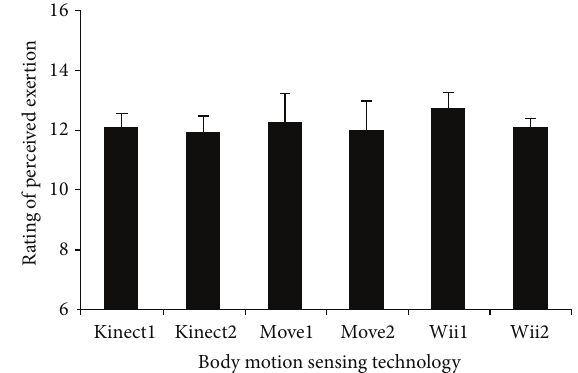
Figure 4: Rating of perceived exertion reported immediately after performing each of the different dance routines using the various differentbodymotionsensingtechnologies.Dataareshownasmean ( 𝑛 = 11 ) and error bars indicate